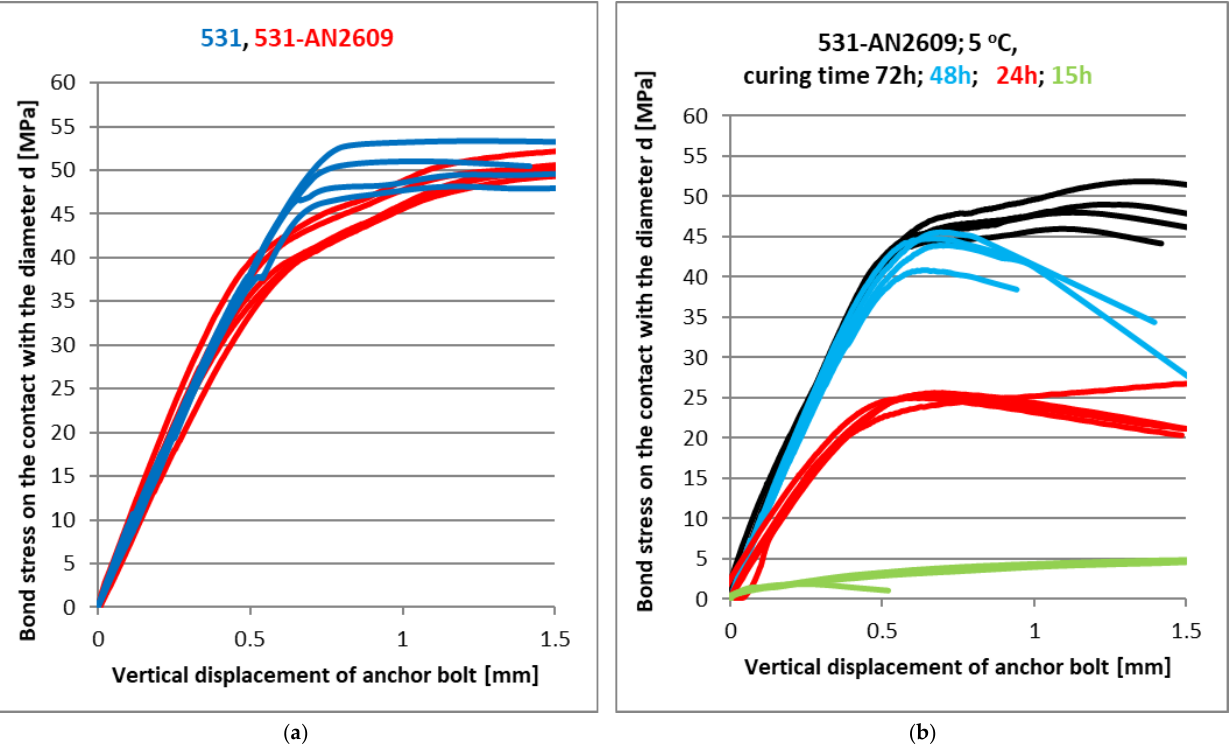
Figure 14. CHS Epoxy 531 with AN2609 curing accelerator; ( a ) Curing at 20 °C; ( b ) Curing at 5 °C.